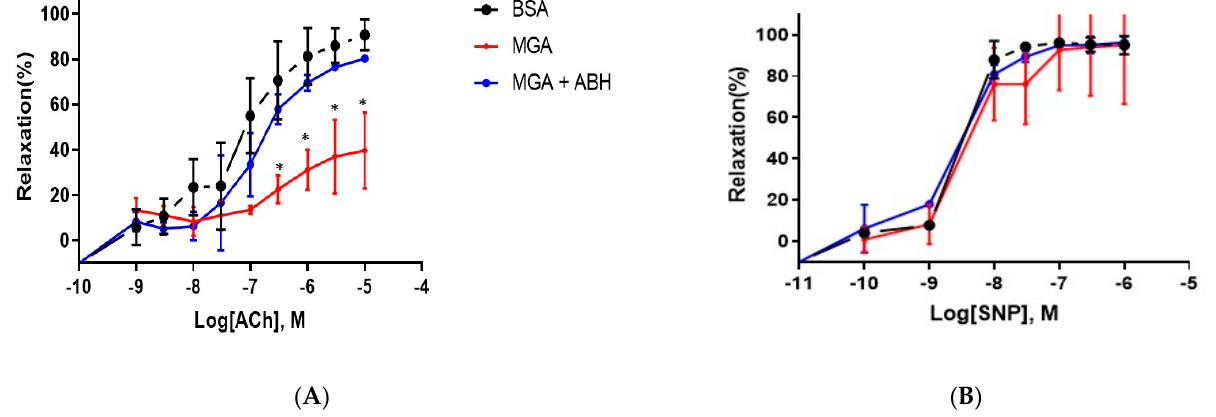
Figure 4. Dose-response relaxation curves for ( A ) endothelium-dependent vasorelaxant acetylcholine (ACh) in phenylephrine (1 µM)-preconstricted aortas from mice; ( B ) endothelium-independent vasorelaxant sodium nitroprusside (SNP) in phenylephrine (1 µM)-preconstricted aortas from mice. Dashed black line indicates responses in control conditions (BSA, 100 µM, 24 h); solid red line indicates responses in MGA-pretreated aortas (100 µM, 24 h); solid blue line indicates responses in MGA-treated aortas pretreated with ABH (1 mM, 24 h). n = 3 in each group; * p < 0.05 MGA vs. control or MGA + ABH.